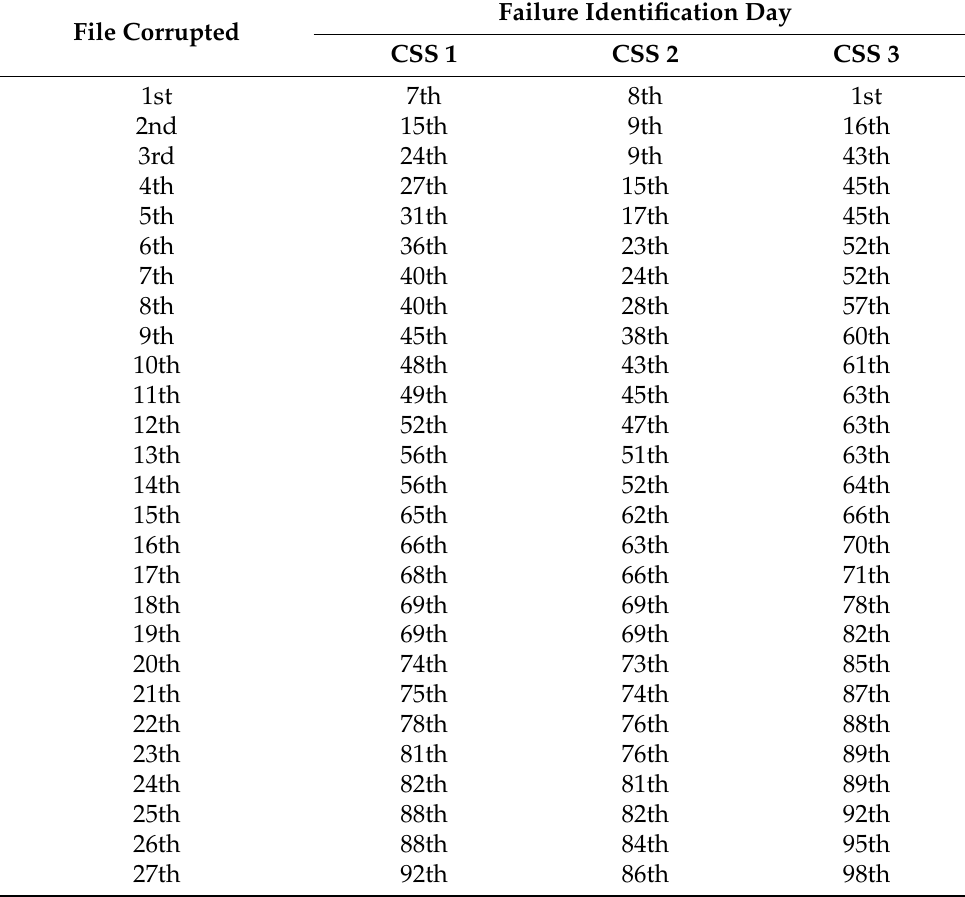
Table 6. Results of validation session per CSS.